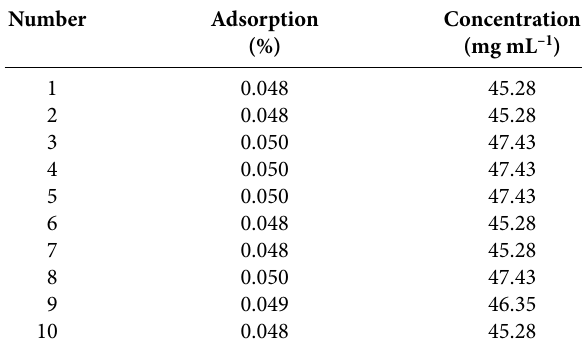
Table 3. Results of repeatability at concentration 100 mg mL –1 .